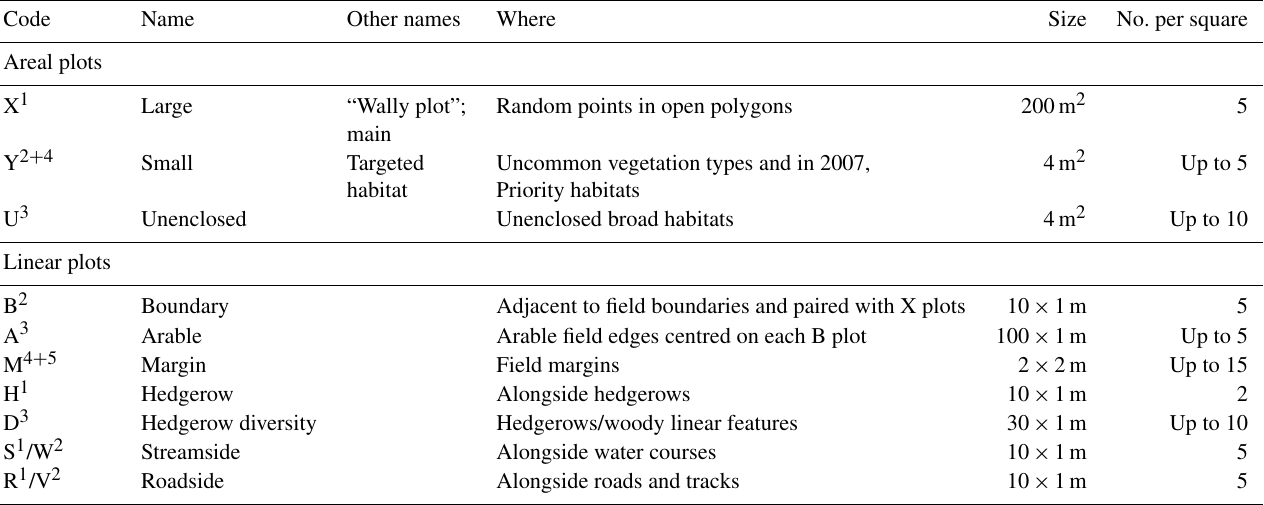
Table 1. Summary of vegetation plot types, sizes and numbers.